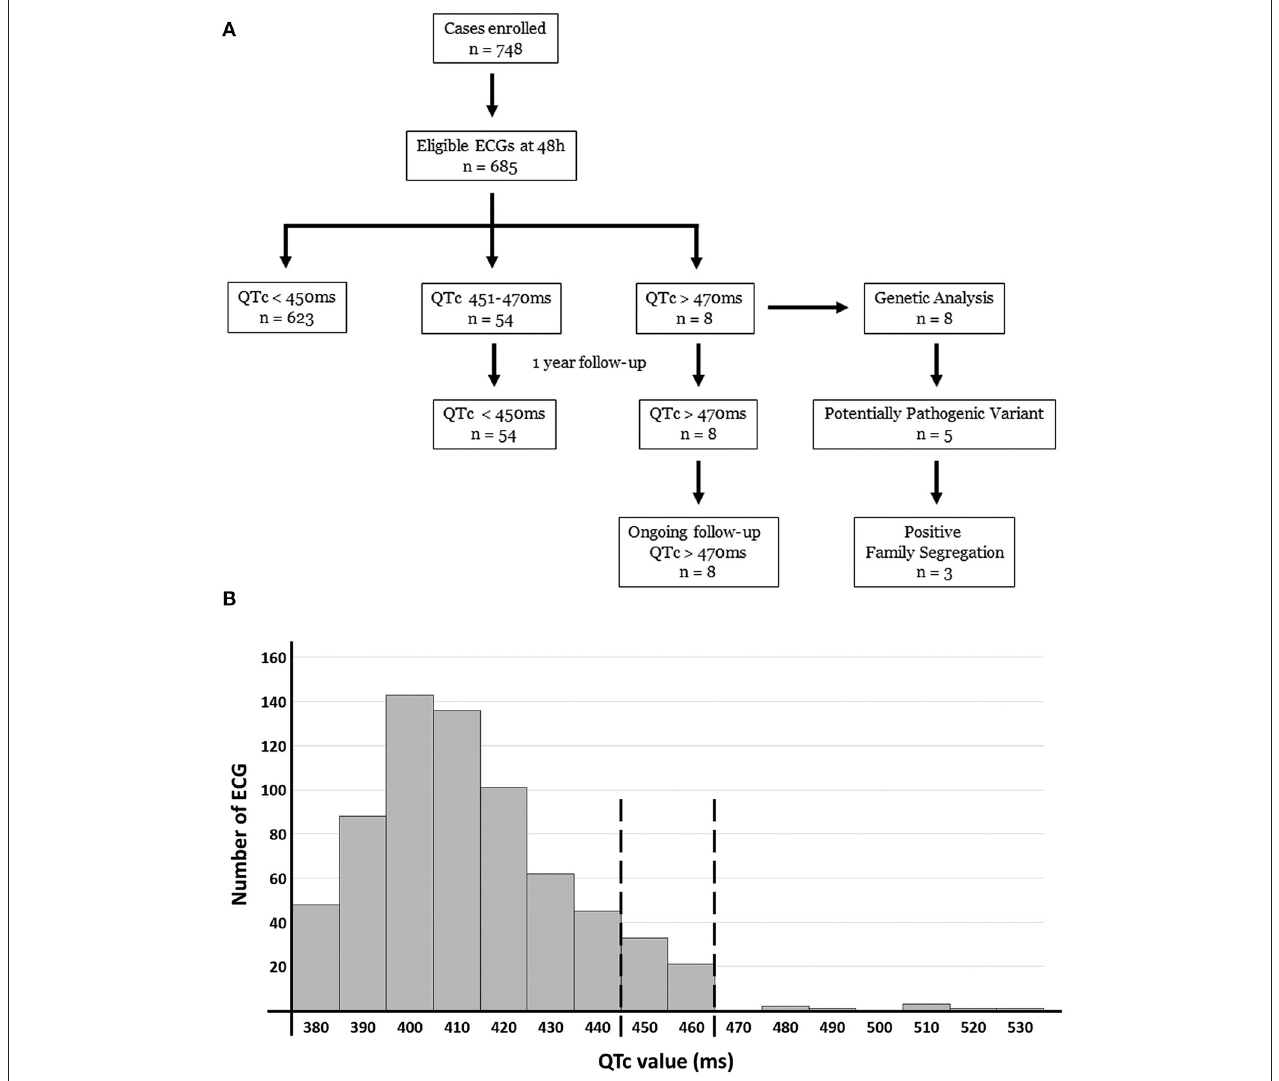
FIGURE 1 | Diagram (A) and histogram (B) of our study population and results obtained. Of 685 ECG included in our study, 8 cases showed a QTc > 470ms at birth. All these 8 cases maintain enlarged QTc and are in clinical follow-up so far. Genetic analysis identified 5 of these 8 cases carrying a potential variant as the most plausible cause of LQTS. In 3 families we observed a